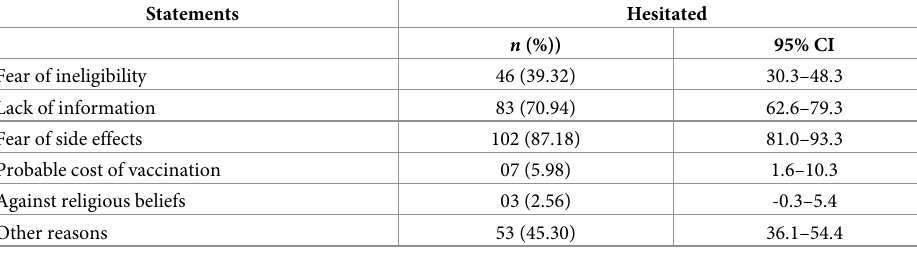
Table 8. Reasons of hesitancy towards COVID-19 vaccine ( n =